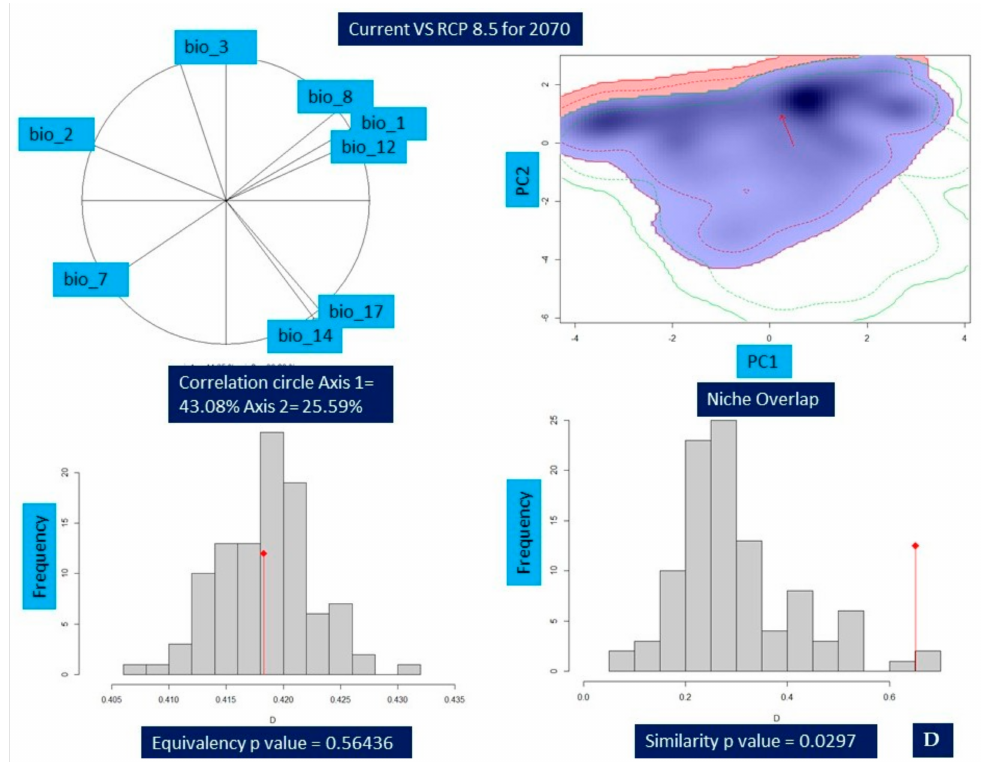
Figure 5. Change in the niche dynamics of Valeriana wallichii under current and future climatic scenar- ios. ( A ) Current vs. representative concentration pathway 4.5 for 2050 ( B ) Current vs. representative concentration pathway 4.5 for 2070 ( C ) Current vs. representative concentration pathway 8.5 for 2050 ( D ) Current vs. representative concentration pathway 8.5 for 2070. The contribution of various bioclimatic variables is provided by correlation circle and depicts the variation percentage of each axis. Blue color represents the density of species in current while red color shows the density of target species in future. Equivalency and similarity results are shown by bar plots, while the red arrow shows the change in the niche between current and future climate